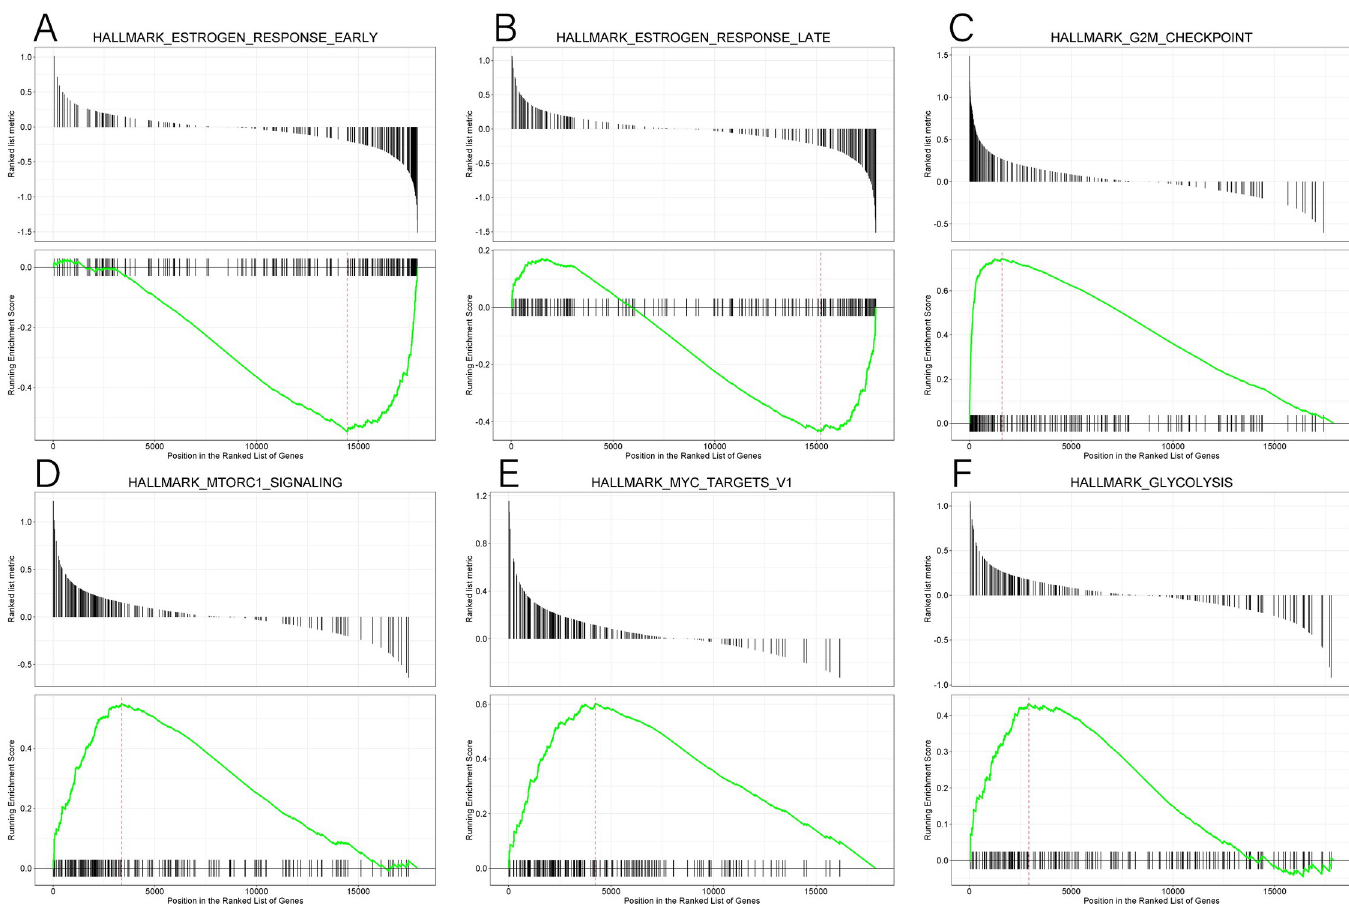
Fig 9. GSEA results of CCBL2 in breast cancer. GSEA results showed the different enrichment of estrogen response early (A), estrogen response late (B), G2M checkpoint (C), mTorc1 signaling (D), MYC targets V1 (E) and glycolysis (F) in CCBL2 related to breast cancer. Abbreviation: GSEA, Gene Set Enrichment Analysis.